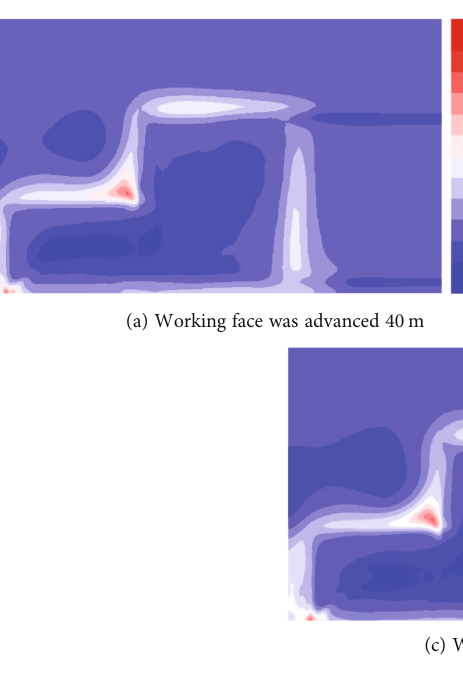
Figure 28: Maximum shear stress of large mining